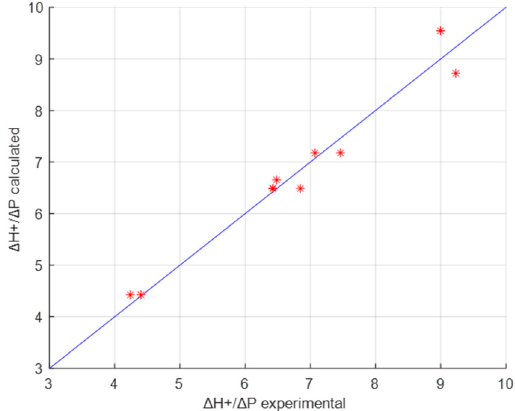
Figure 6. Comparison of the experimental (*) and calculated values of y = Δ H + / Δ P for Toolse 1 sample according to model 5.